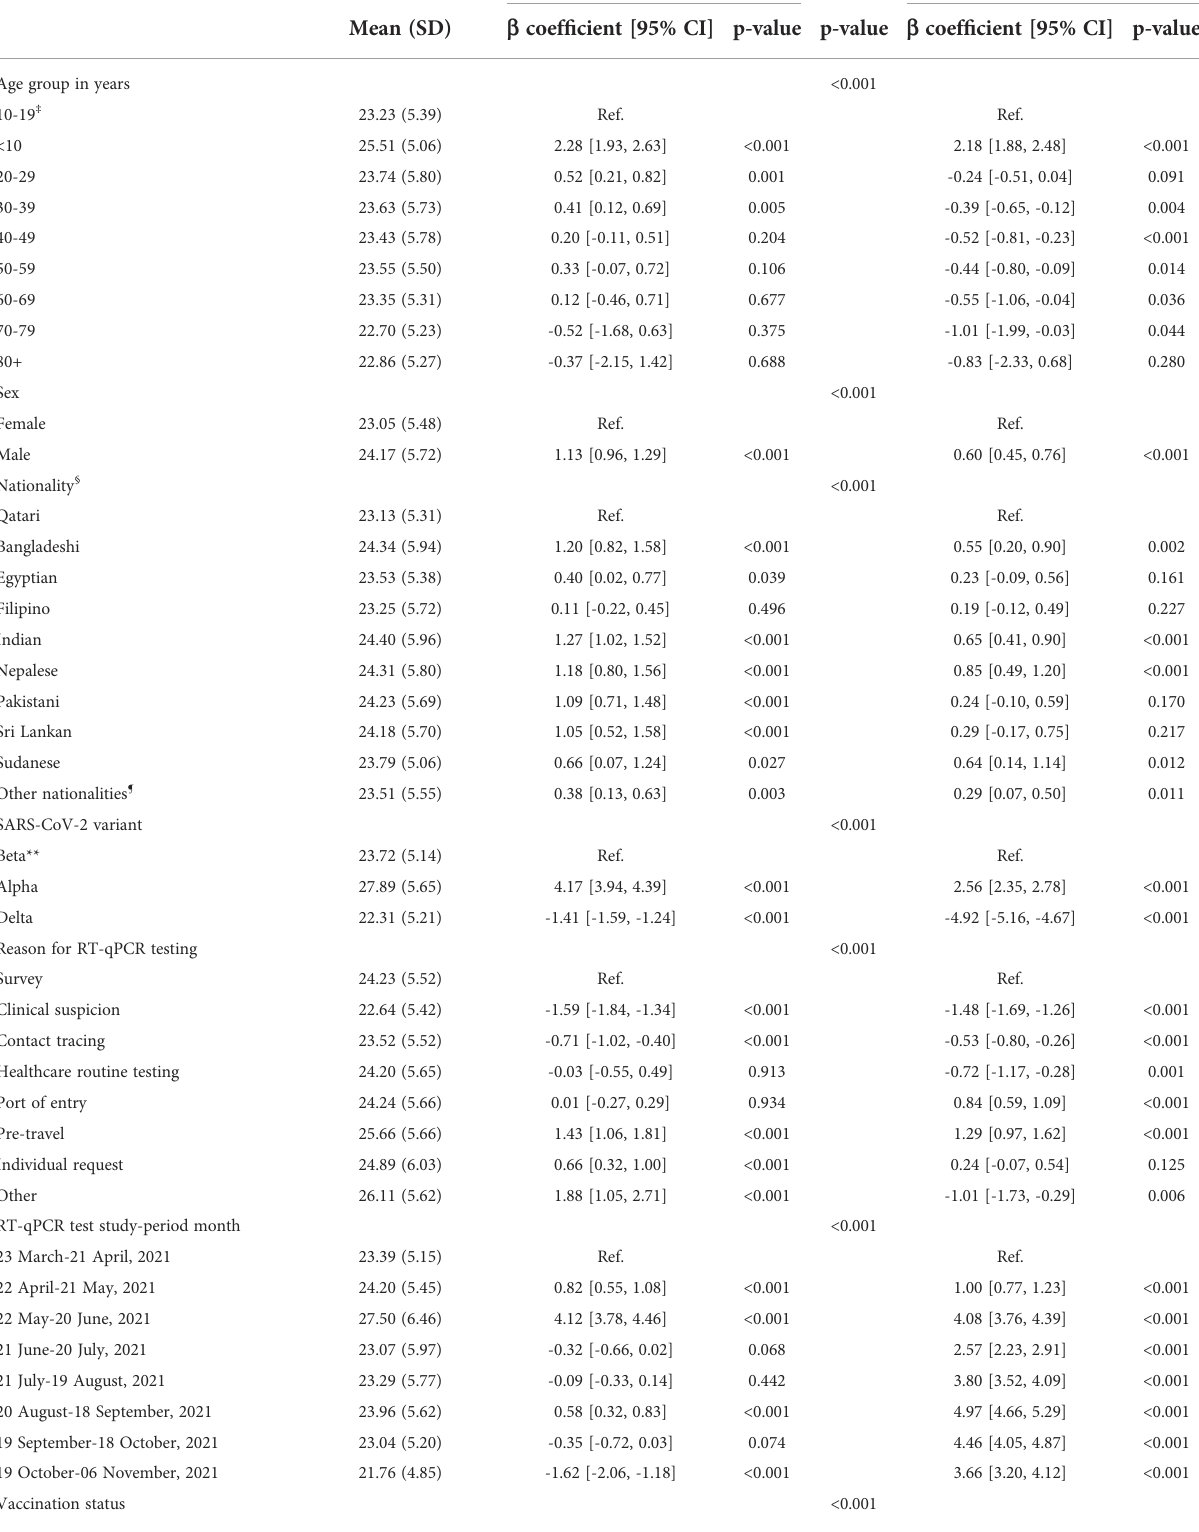
TABLE 2 Associations with RT-qPCR Ct value among the 18,355 RT-qPCR-genotyped SARS-CoV-2 infections between March 23 and November 6, 2021.